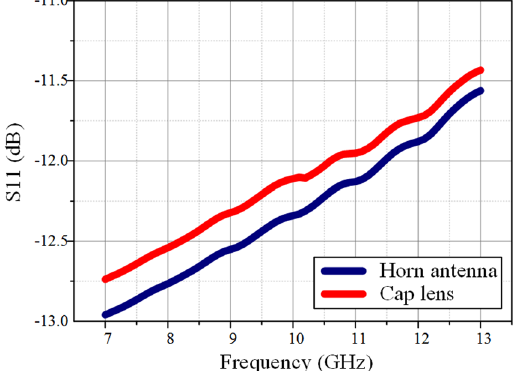
Figure 9. Simulated S 11 coefficient distribution of the conical horn antenna alone and the horn antenna with the 3D discrete